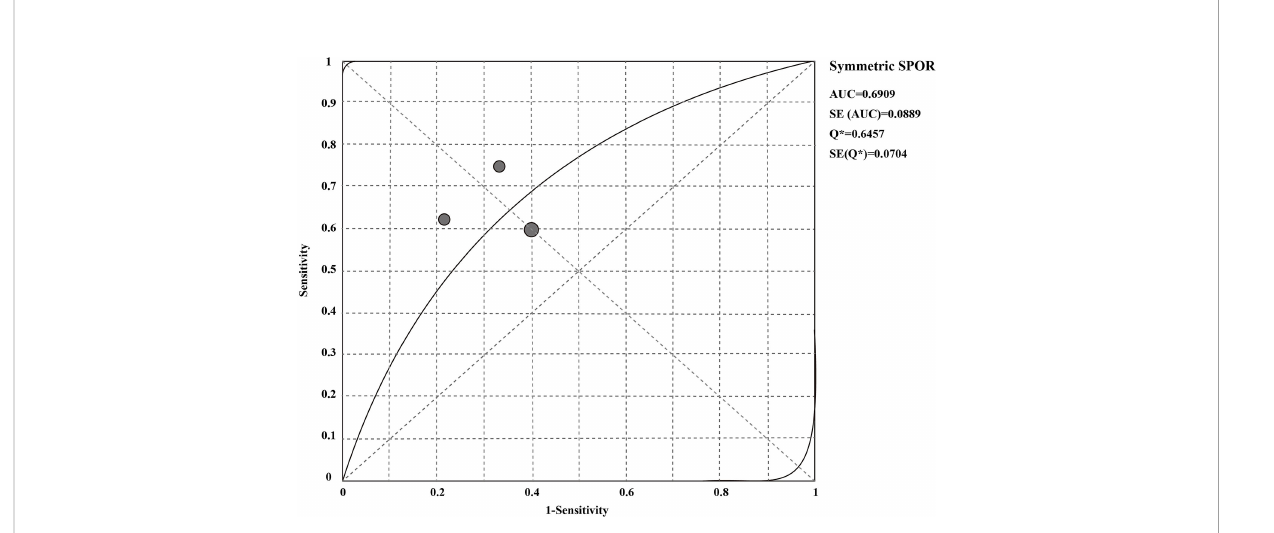
FIGURE 4 SROC curve of CSF liquid biopsy in the diagnosis of LM.